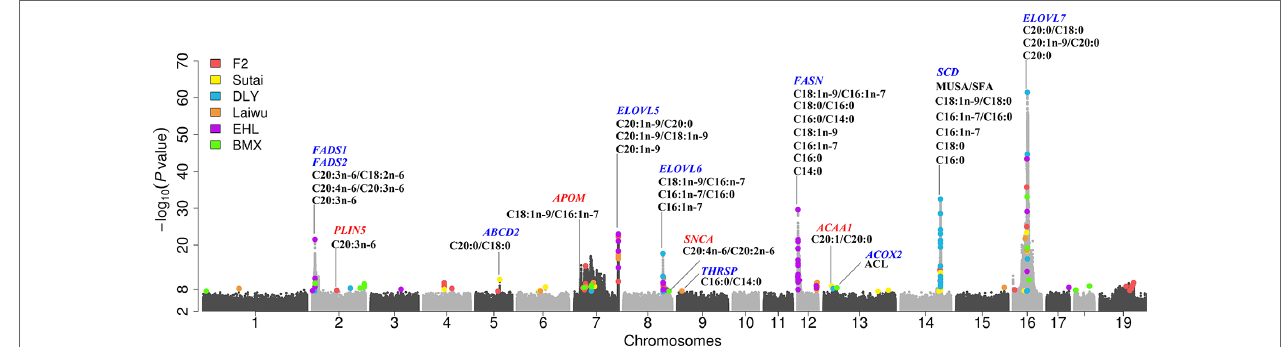
FIGURe 2 | A combined Manhattan plot for GWAS on fatty acid composition traits across six populations. Genome-wide representation of all lead SNPs identified single population GWAS, which were marked by a colored dot. Results from different populations were represented by different colors. The y axis shows the -log 10 p- values for association with corresponding fatty acid composition traits and the x axis shows the genomic position of genetic variants. Candidate genes are denoted with different colors, blue for candidate gene previously identified, and red for candidate gene newly found in current